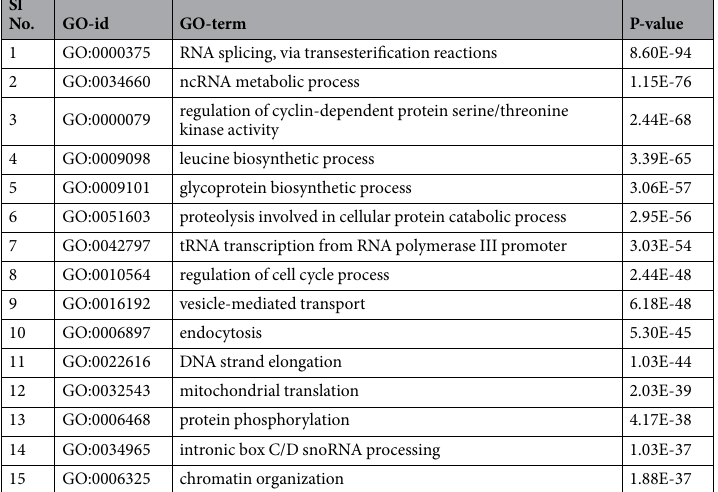
Table 4. GO-terms, GO-id and p-value of top 15 identified complexes.